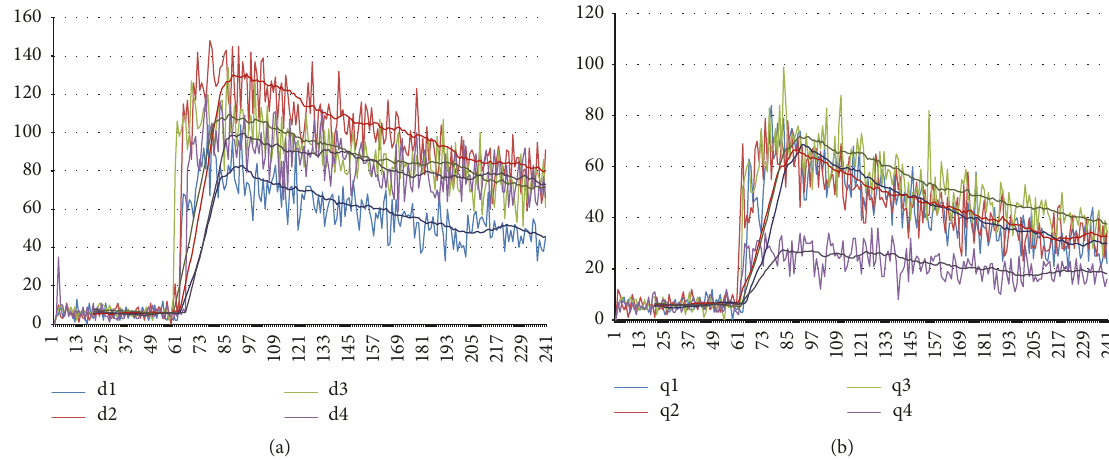
Figure 6: Results of ultra-weak photon emission measurements after mixing 0.5 ml of 10 mM tert-Butyl hydroperoxide with 1ml of deionized water . The duration of measurement is 3 min. The vertical axis represents the number of photons per second and the horizontal axis represents seconds elapsed. (a) Deionized water. The number of photon emissions increased compared to day 1 (d1, d2, d3, and d4 indicate the day of measurement, resp.). (b) Deionized water treated in the noncontact manner. The number of photon emissions decreased drastically at day 4 (q1, q2, q3, and q4 indicate the day of measurement, resp.).